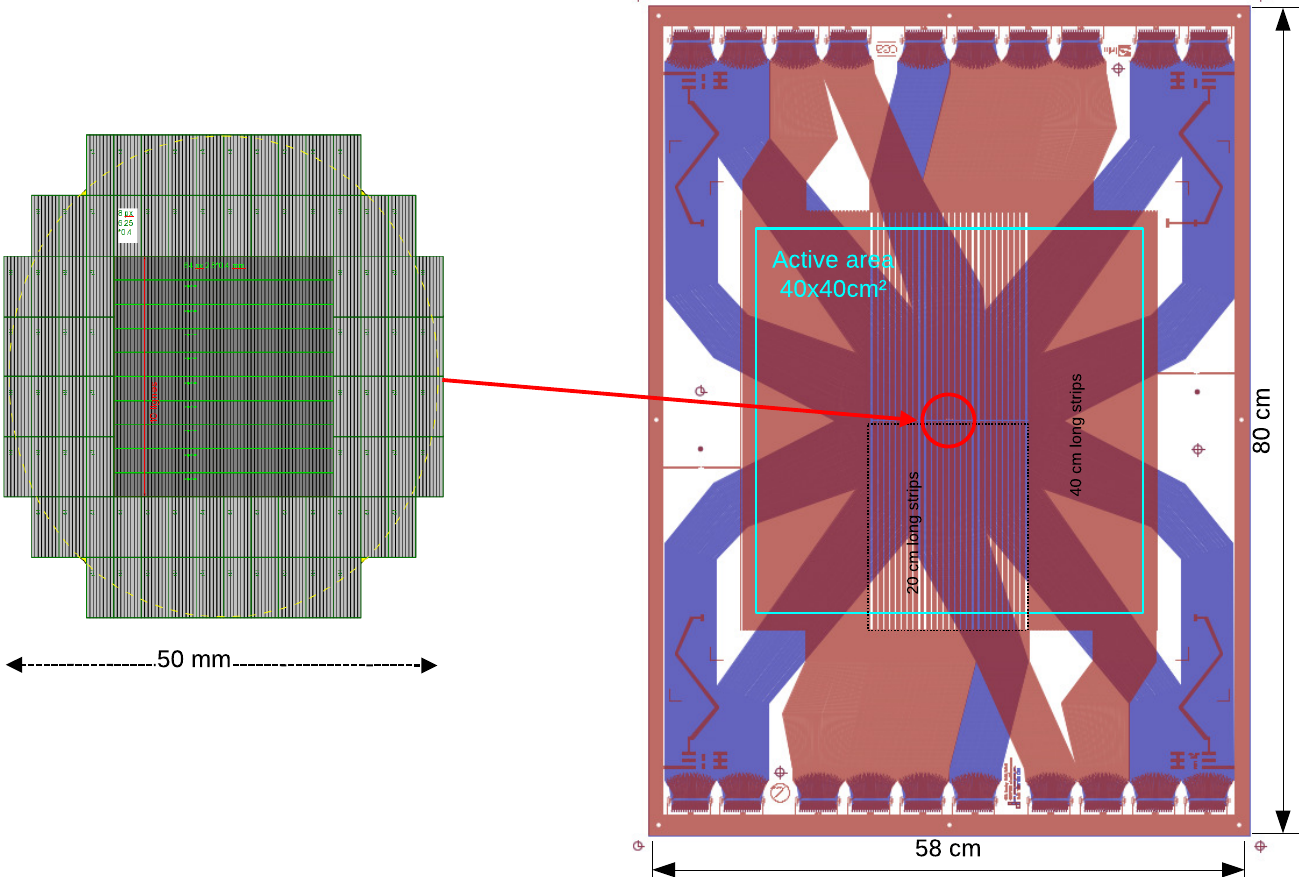
Figure 9. Scheme of the Compass pixelated Micromegas plane. The left figure shows the detail of the pixelated area in the center of the plane. On the right figure, the red lines are the readout strips on the top side of the board, and the blue ones are the strips used to extract the pixel signals on the bottom